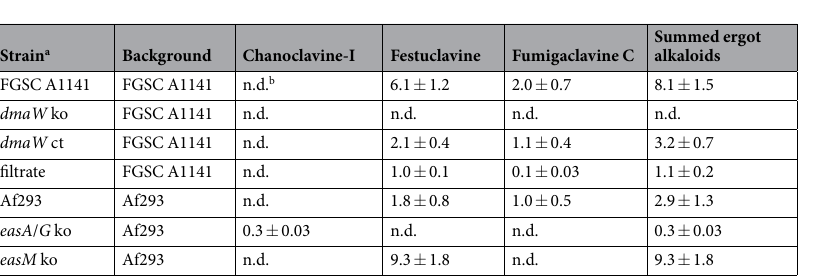
Table 2. Mean ergot alkaloid concentrations ( μ M; mean ± standard error) in Neosartorya fumigata conidial extracts injected into Galleria mellonella larvae. a ko, knockout; ct, complemented; filtrate, conidia removed by filtration prior to addition of methanol. b n.d., not detected; limit of detection 0.07 μ